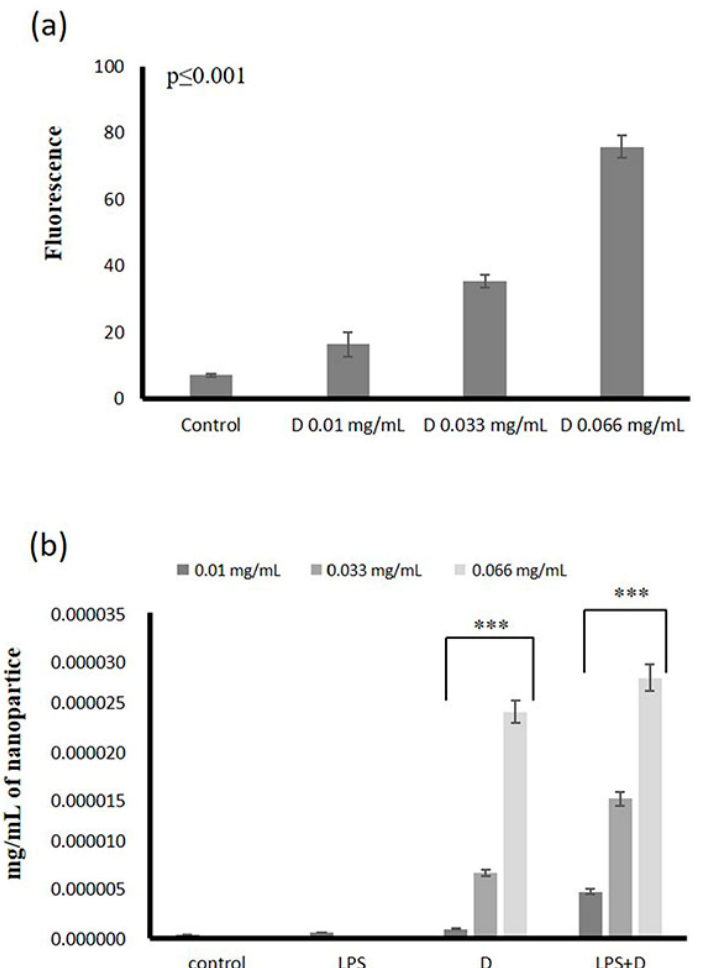
Figure 6. Uptake of DNPs by HMEC-1 cells. ( a ) Concentration-dependent fluorescence of DNPs; ( b ) uptake of DNPs (D) by normal and LPS-activated endothelial cells expressed as mg/mL of cell extracts. The cells were cultured in 96-well plates, in some cases activated with LPS, and treated with DNPs (D) for 48 h. The results represent the average of three separate experiments. Statistical significance: *** p ≤ 0.001 compared to respective controls.